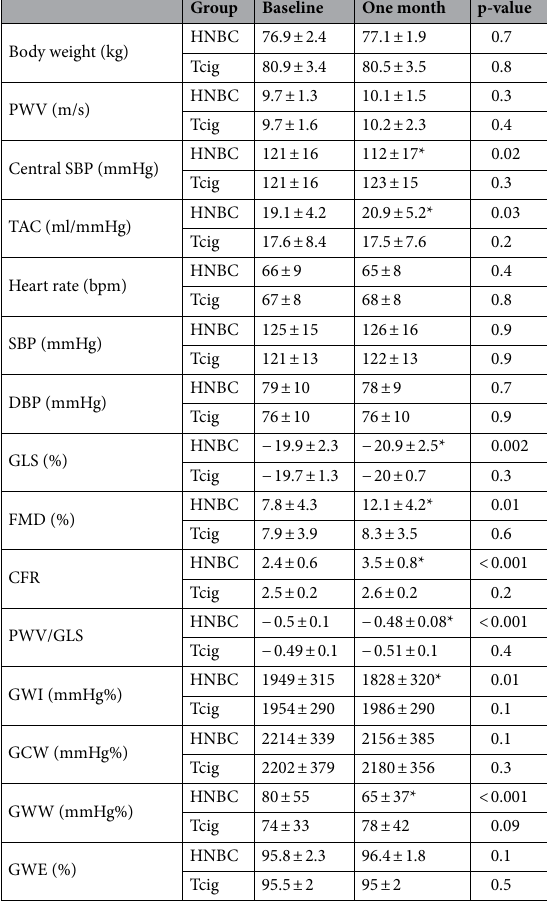
Table 3. Arterial elasticity, myocardial deformation, endothelial function, and ventricular-arterial coupling progression after 1 month of switching from tobacco cigarette smoking to heat-not-burn product puffing (n = 50) compared to tobacco cigarette smokers (n = 25). *p < 0.05 for interaction with group, derived from post hoc analysis by ANOVA. HNBC heat-not-burn cigarette, TCig tobacco cigarette, CFR coronary flow reserve, PWV carotid-femoral pulse wave velocity, FMD flow-mediated dilation, GCW constructive myocardial work, GLS global longitudinal strain, GWE myocardial work efficiency, GWI global myocardial work index, GWW wasted myocardial work, values are